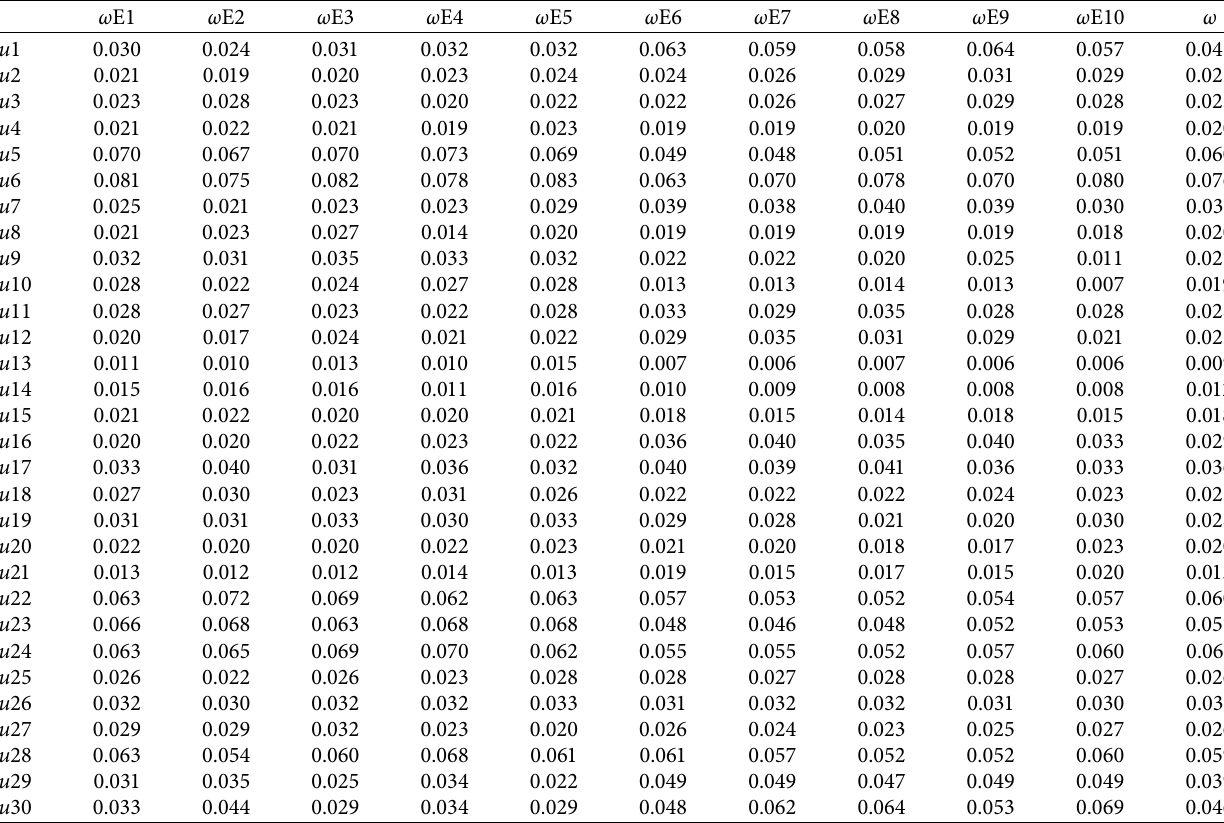
Table 13: Evaluation results of risk factor weight by